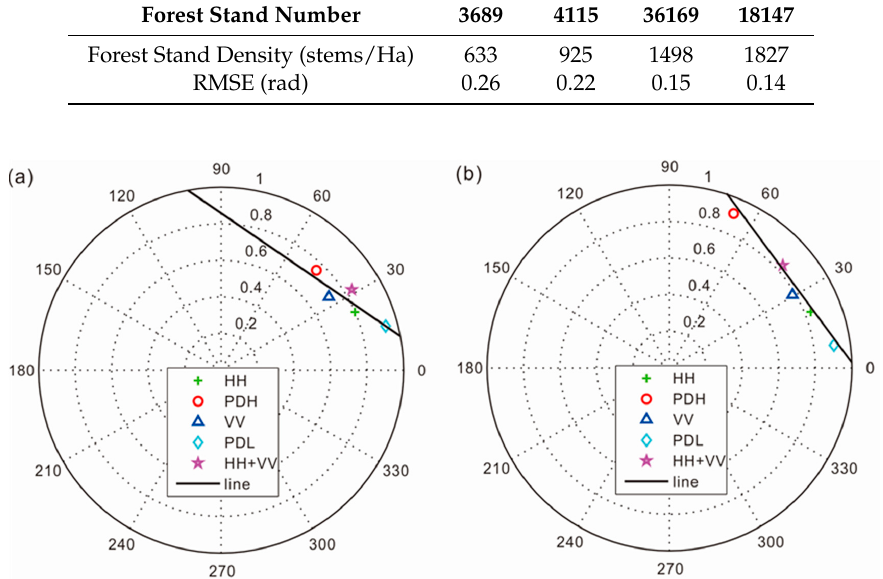
Figure 8. Relative height of phase centers for different density.